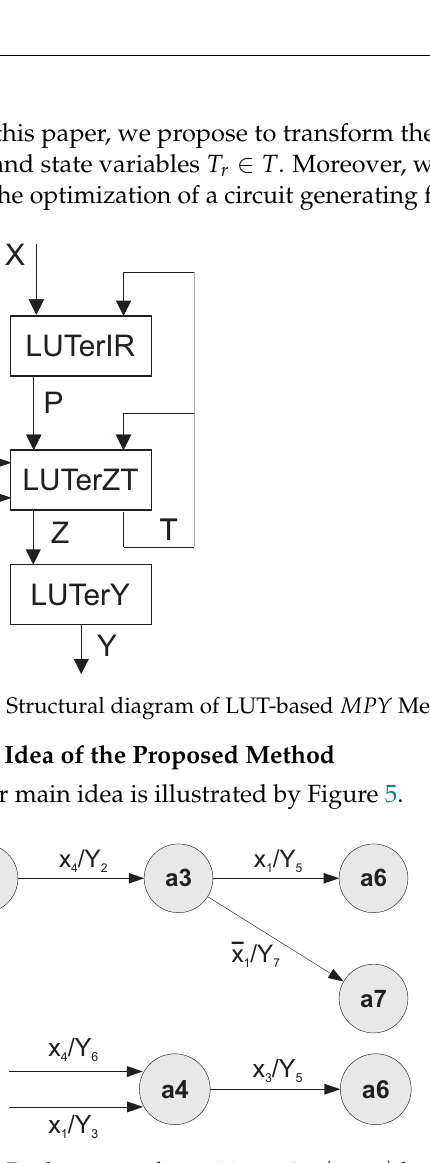
Figure 5. Replacement of transition pairs